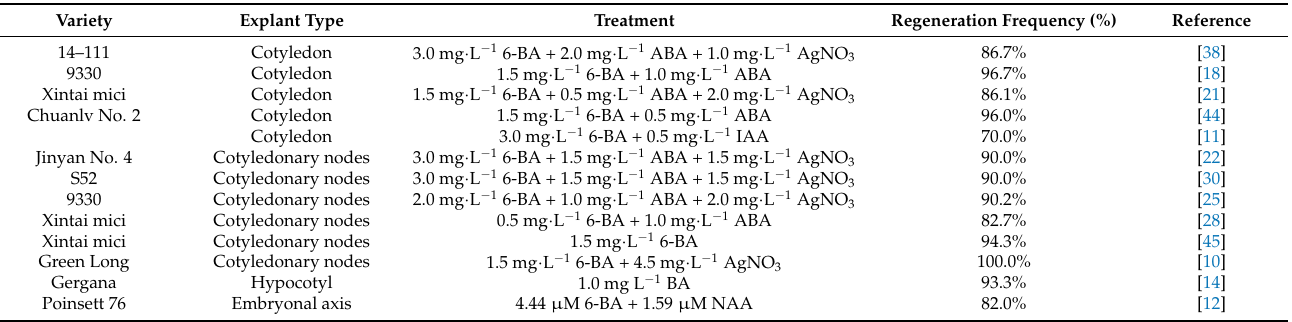
Table 1. Application of plant hormones and AgNO 3 in the explant bud induction stage of different varieties of